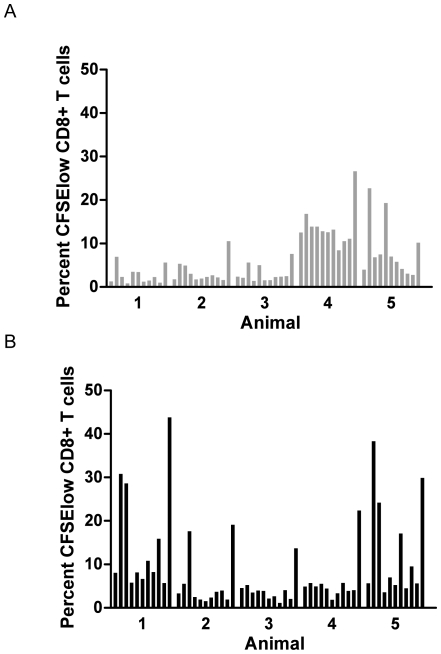
Proliferative CD8+ T cell responses induced after immunization with IFA and CAF01.The percentage of proliferating CD3+CD8+ splenocytes (having reduced CFSE dye) derived from HLA-A*0201 transgenic HHD mice 10 days after s.c. immunization with a peptide mix consisting of 10 peptides adjuvanted with (A) IFA or (B) CAF01. The background proliferation of non-stimulated (NS) cells, incubated with media alone is shown. The epitope peptides were (from left to right): NS, Gag150, Gag433, Env67, Pol606, Vpu66, Vif101, Vif23, Gag298 (Th), Env570 (Th) and PADRE (Th).